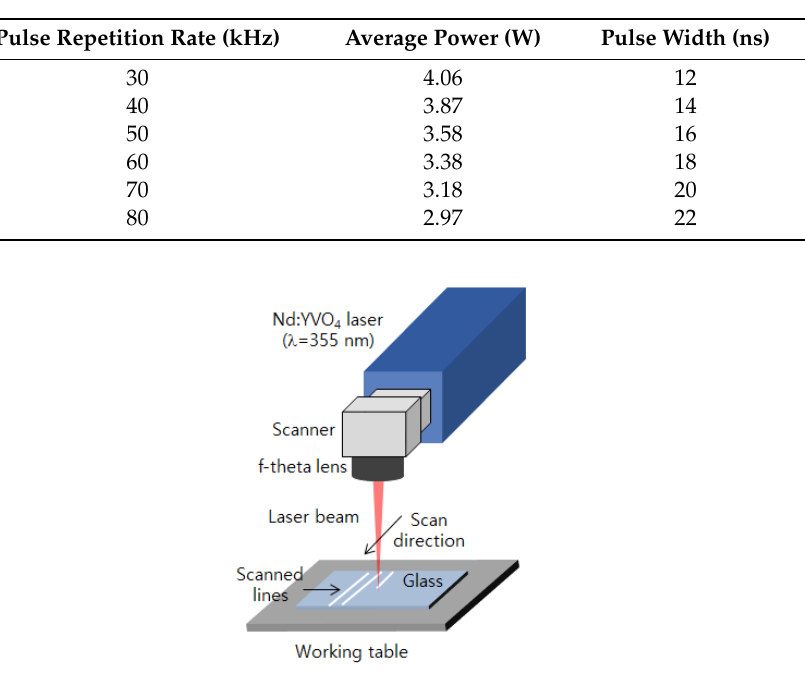
Table 1. Pulse width of the Nd:YVO 4 (355 nm) laser at different pulse repetition rates (data from INNGU LASER).